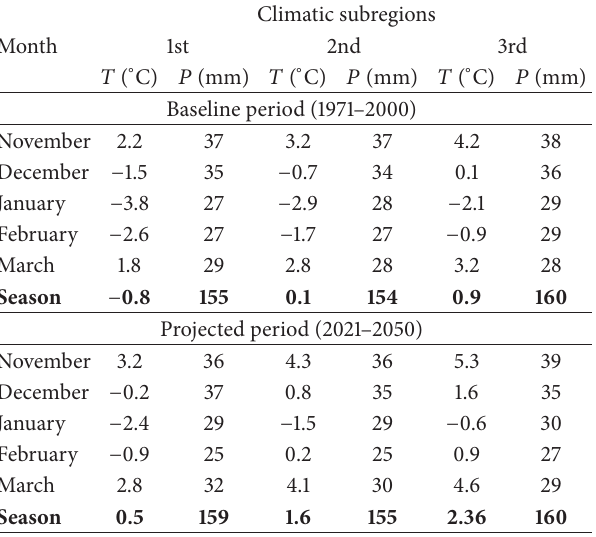
Table 3: Temperature and precipitation conditions of a cold season in the Moldavian part of the Dniester